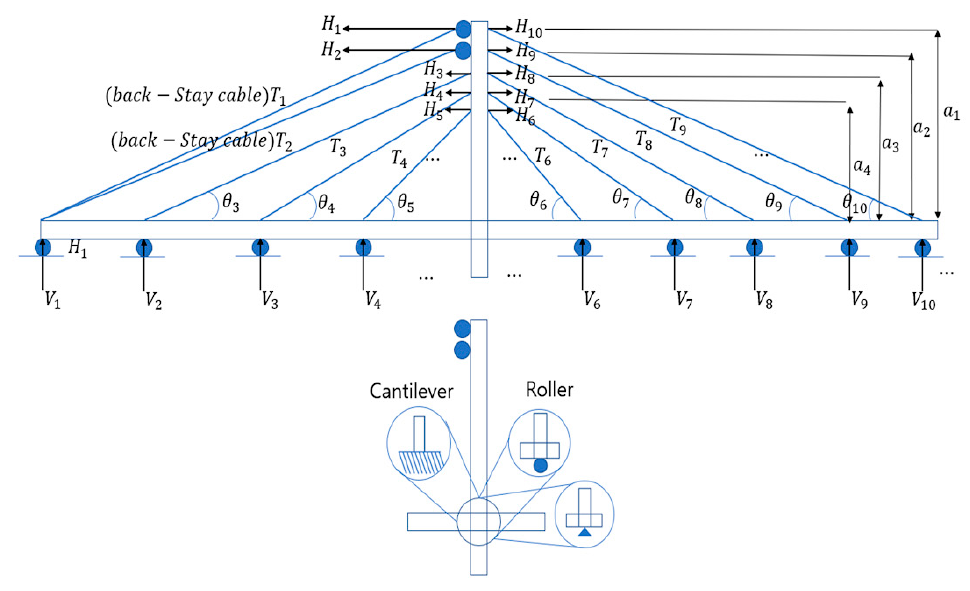
Figure 12. Temporary support